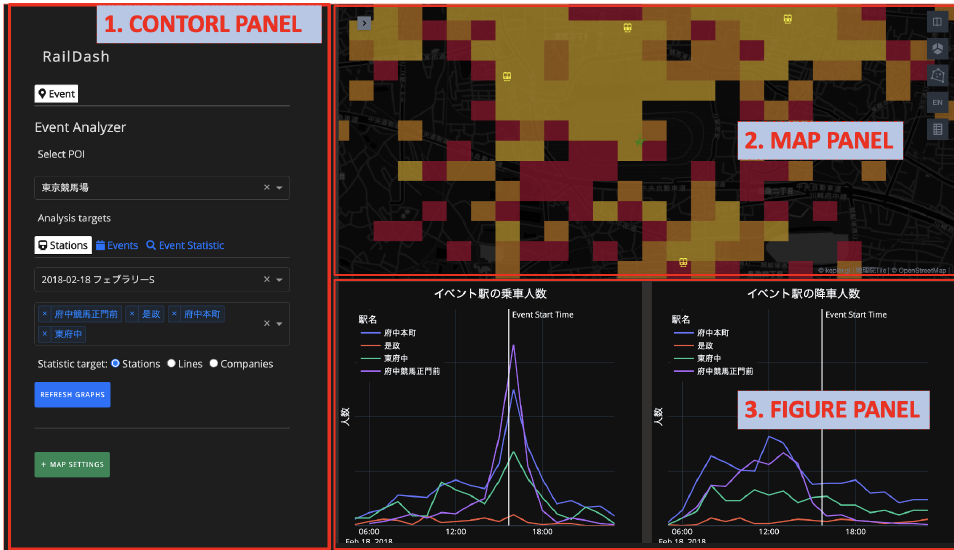
Figure 3. The Layout-design of the